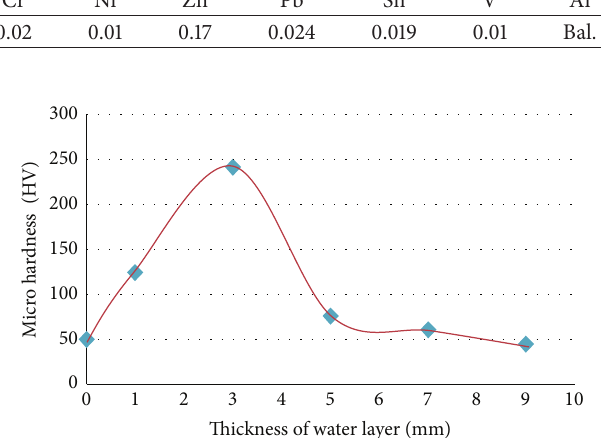
Figure 4: Microhardness [HV] of 2024-T3 aluminum after different LSP pulse energies.